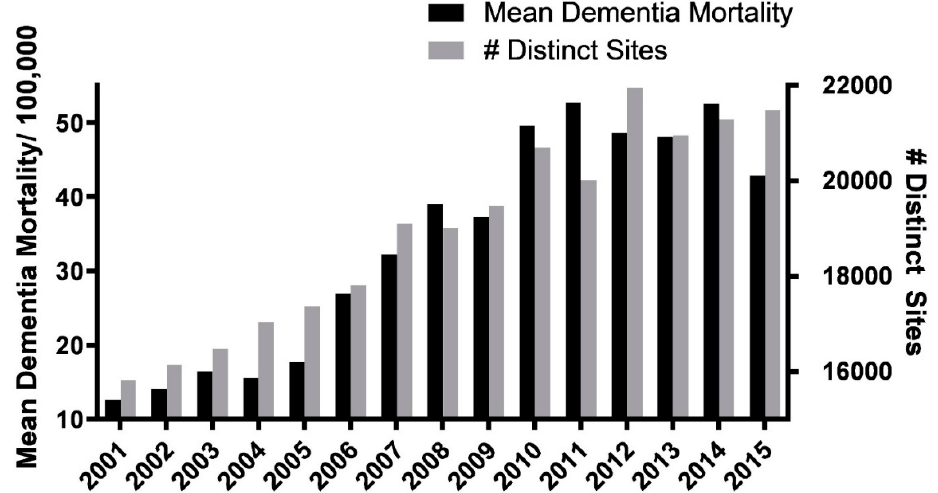
Figure 6. Distinct sites vs. mean mortality. Graphic illustration of nearly identical trajectories of increase in the numbers of distinct MTM sites (total sites) vs. the mean age-adjusted mining county vascular and unspecified dementia mortality rates/100,000 population between 2001 and 2015.